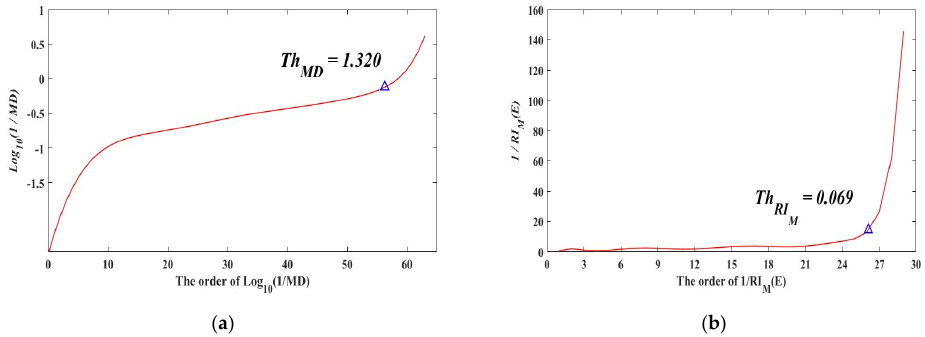
Figure 8. The optimal threshold of merging evolution for the simulated dataset. The triangle symbol is located at the inflection point of the curve, and the equation represents the value of the corresponding variable at the inflection point. ( a , b ) are merging degree and relative importance of being merged objects,